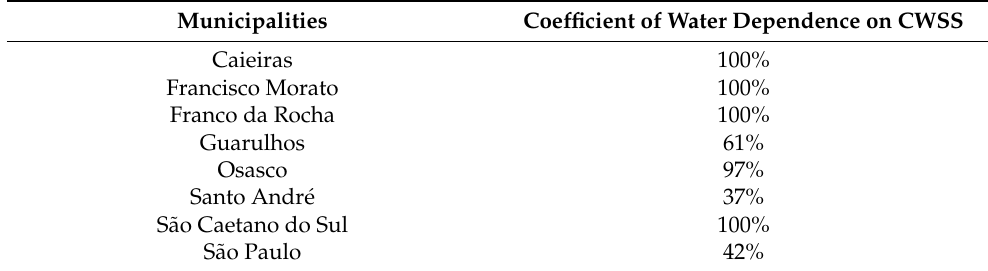
Table 1. Municipalities’ dependence on the Cantareira water supply system. Municipalities Coefficient of Water Dependence on